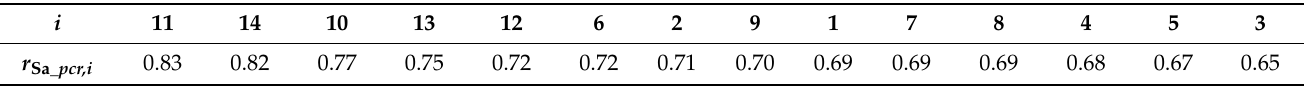
Table 4. Rates of strength of CRs for particular AoSSCRdLs A S_ pcr , i i = 1, 2, . . . , 14 in the order of